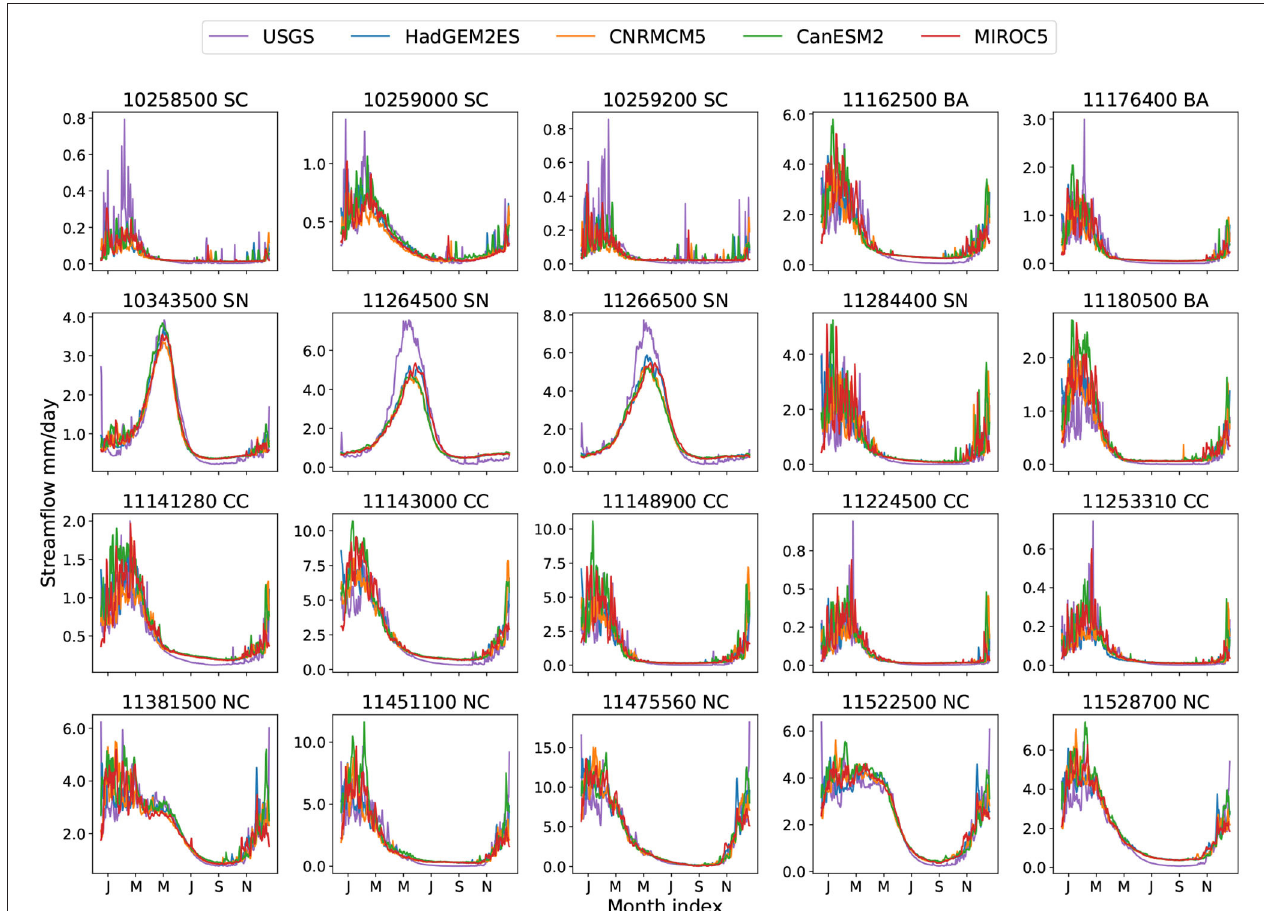
FIGURE 6 | Historical climatological daily streamflow from USGS and four climate